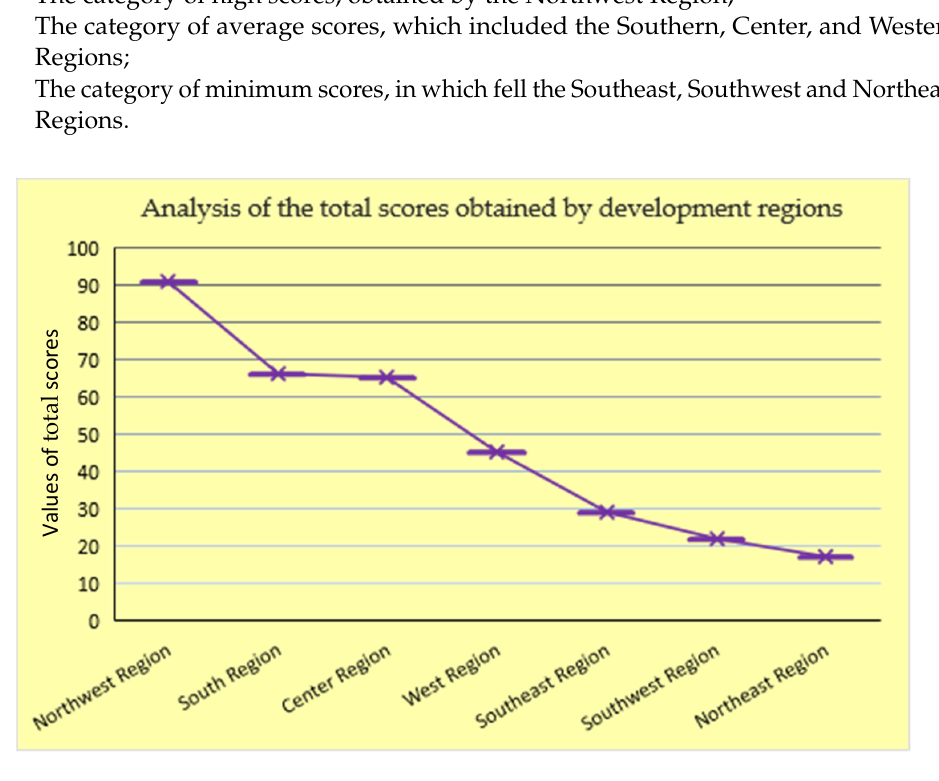
Figure 5. Graphical distribution of the total scores obtained by the regions analyzed (Authors’ own source). Additionally, taking into account the fact that the analyzed regions consist of either two, three, or four companies each, for a unitary approach as a result of the eco-learning criteria evaluation, an analysis of the average scores obtained by the regional operators was carried out, which was related to the development regions from which they came.